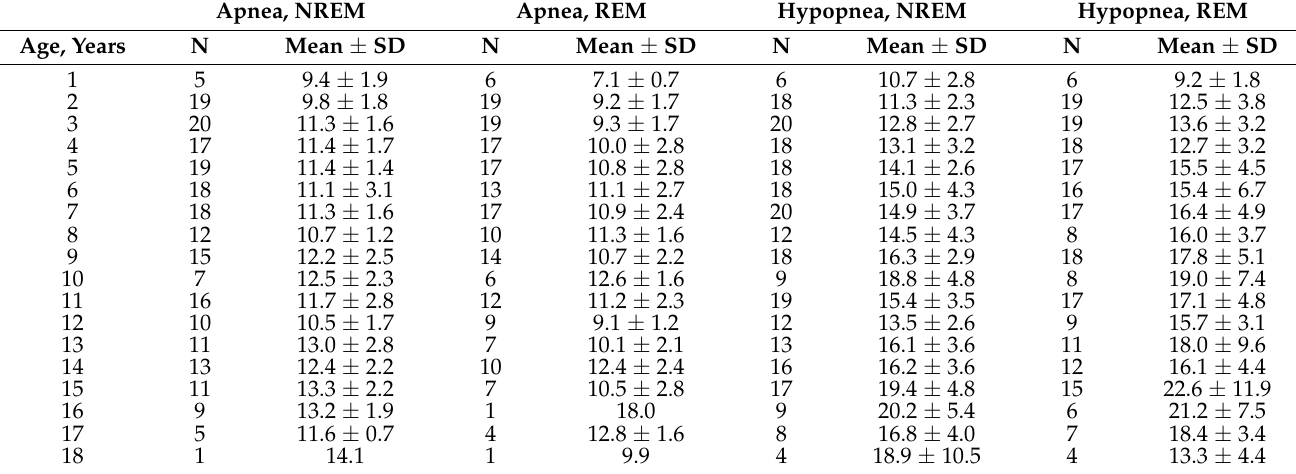
Table 2. Mean duration of apnea and hypopnea events, during NREM and REM sleep, separately, for each age